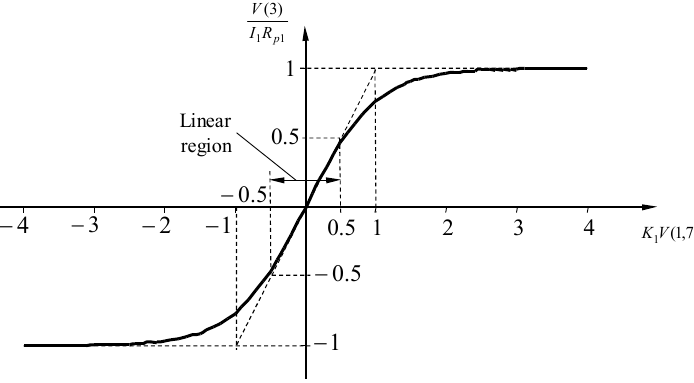
Figure 5. DC open-loop transfer function of the intermediate stage at large input signal.